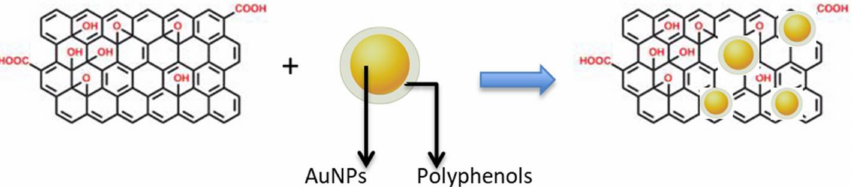
Figure 4. Schematic illustration of AuNPs anchored on the surface of reduced graphene oxide (rGO).